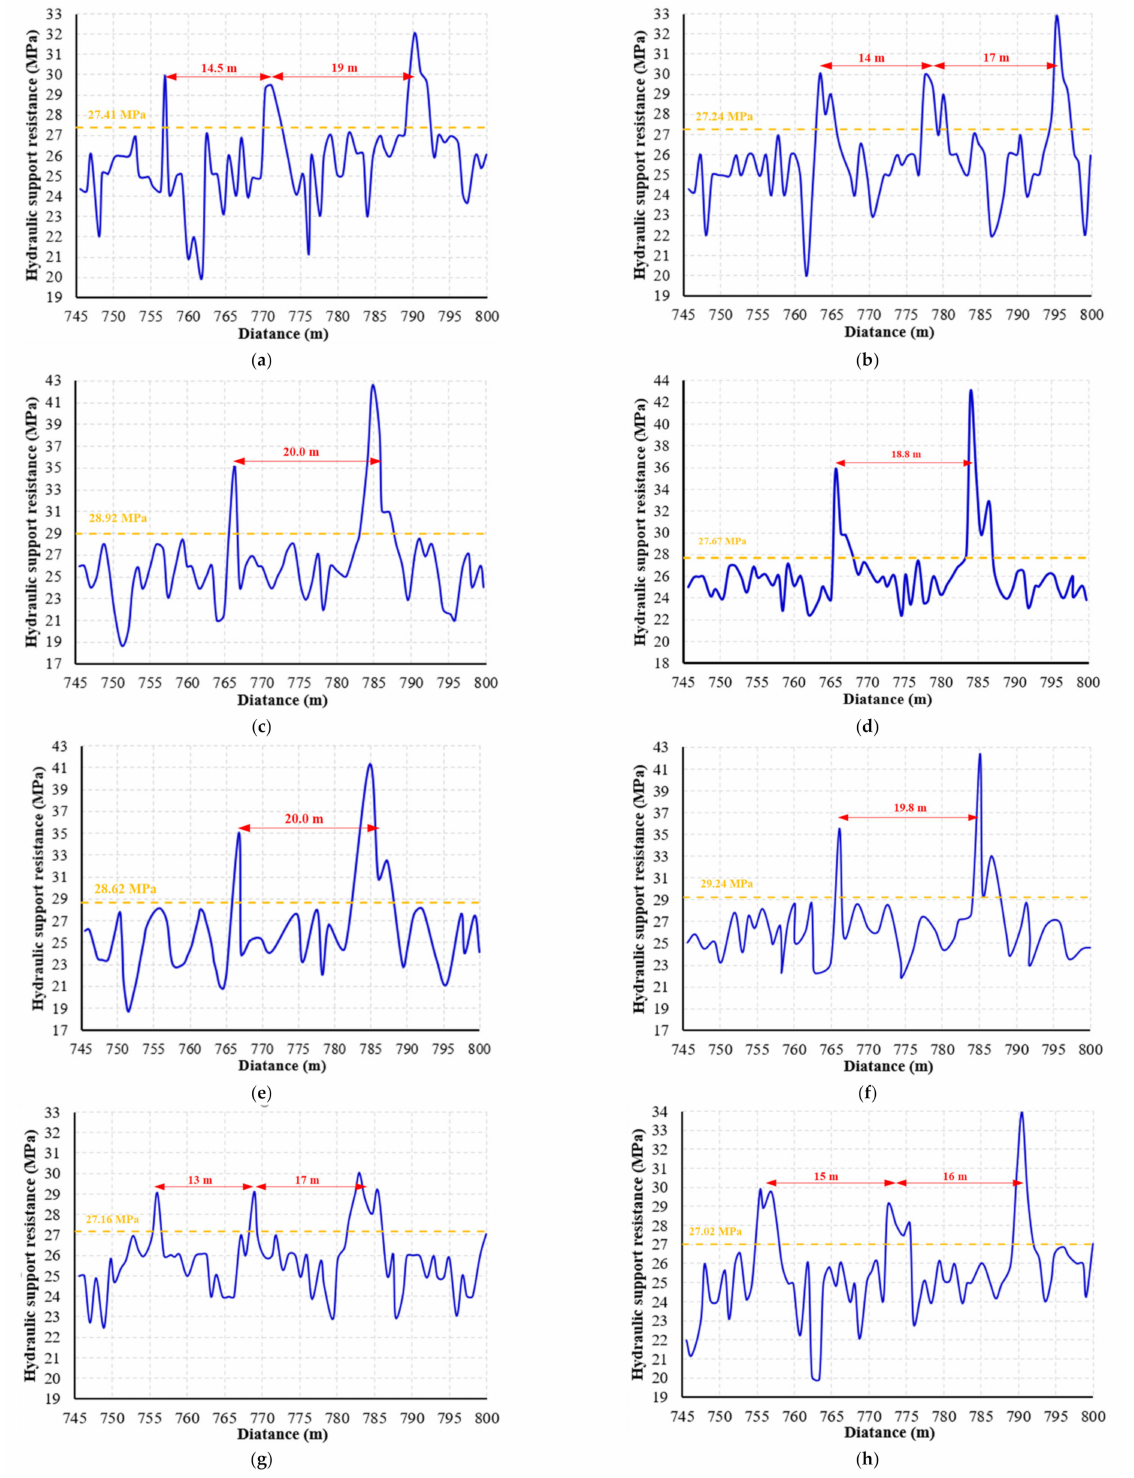
Figure 4. Monitoring results of the hydraulic support resistance during mining in 42,114 working face. ( a ) Resistance of 15# hydraulic support; ( b ) Resistance of 20# hydraulic support; ( c ) Resistance of 70# hydraulic support; ( d ) Resistance of 78# hydraulic support; ( e ) Resistance of 115# hydraulic support; ( f ) Resistance of 121# hydraulic support; ( g ) Resistance of 160# hydraulic support; and ( h ) Resistance of 168# hydraulic